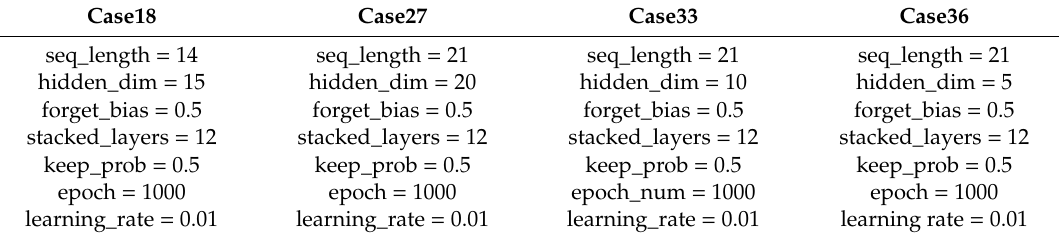
Figure 3. Data prediction method using Long short-term memory. Table 3. Selected experimental cases to find forecasting model parameters.